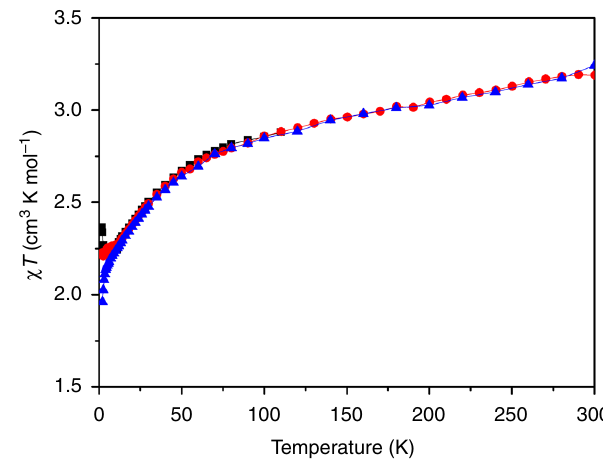
Fig. 3 Variable temperature SQUID magnetometric data of powdered 3 in the solid state. Magnetic susceptibility temperature product ( χ T ) vs. temperature in 1 (black square), 5 (red circle), and 10 (blue triangle) kG applied magnetic fi elds. Lines are a guide to the eye